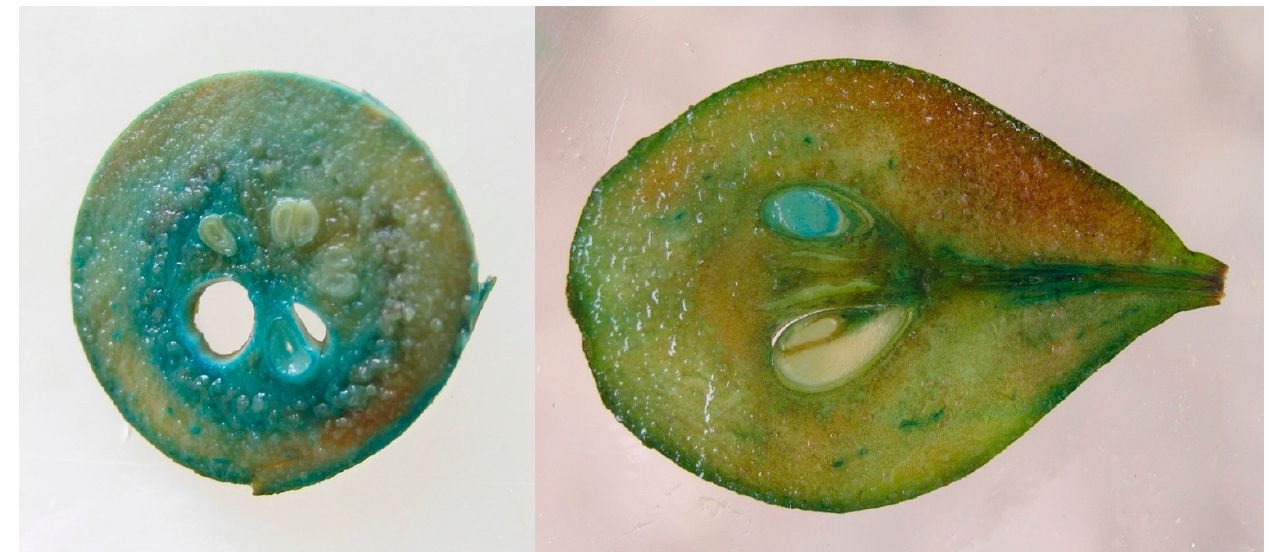
Figure 1. GUS staining of pear fruits: ( left ) transverse section; ( right ) longitudinal section.